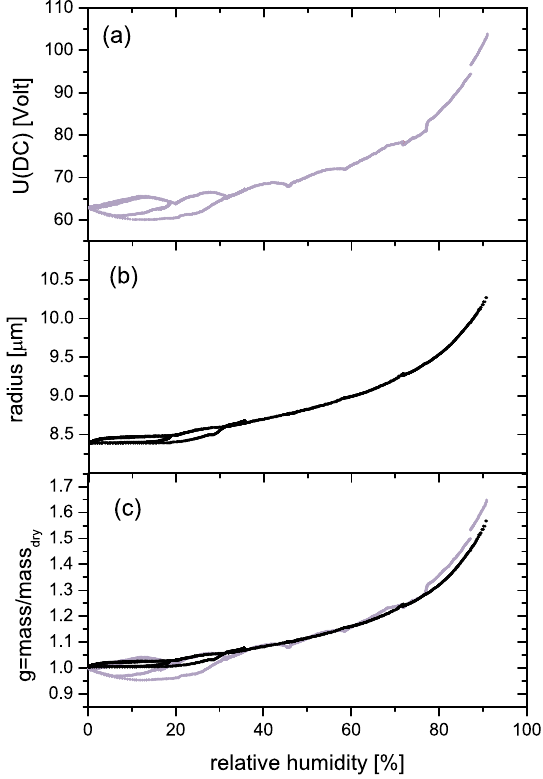
Figure 3. Data of Fig. 2 plotted vs. relative humidity. (a) DC voltage compensating gravitational force. (b) Radius data, see text on how to obtain those from the data of Fig. 2d. (c) Mass to dry mass ratio (growth factor g ) calculated from both voltage (gray) and radius data